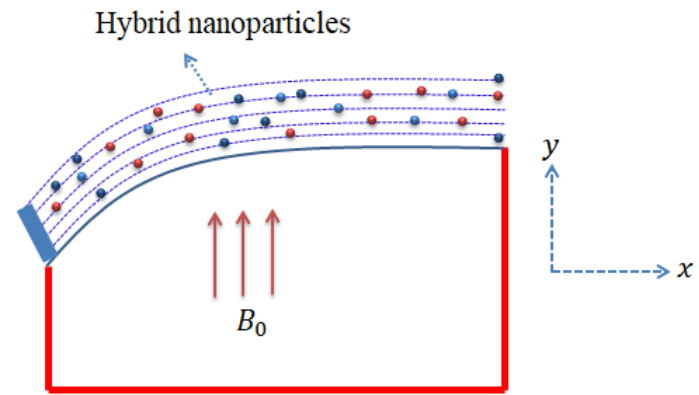
Figure 2. Geometrical sketch of flow problem.